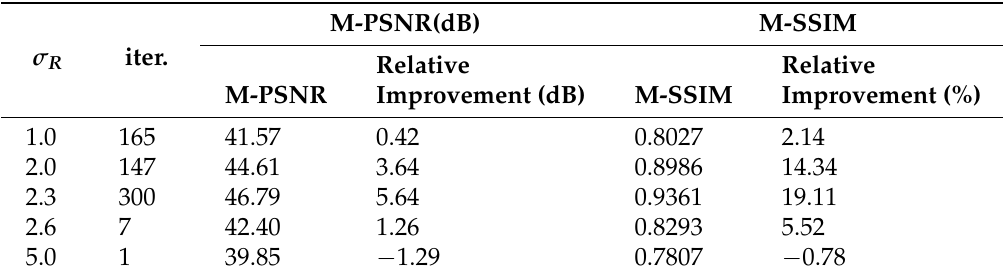
Table 3. M-PSNR and M-SSIM at the minimum M-RRE for different kernels running the accelerated RL